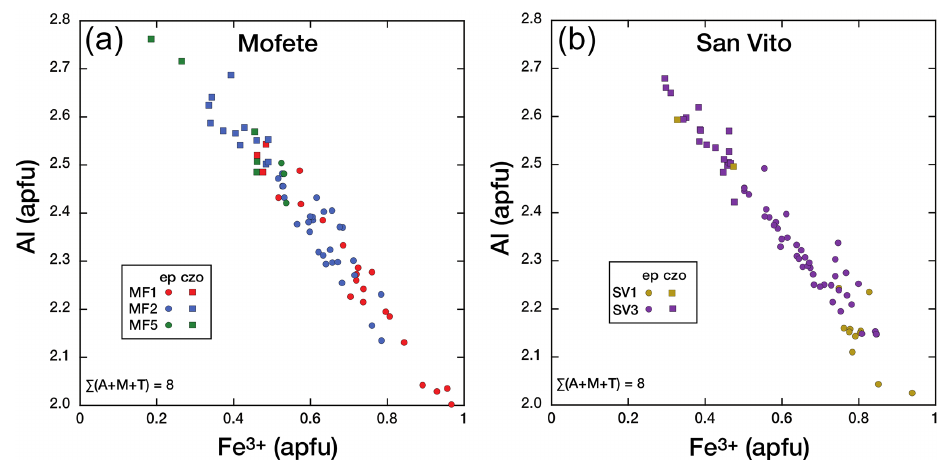
Figure 5. Co-variation in Al and Fe 3 + (apfu) in the epidote group for the three Mofete cores (a) and the two San Vito cores (b) . Epidote (ep) is shown as a solid circle and clinozoisite (czo) as a solid square.